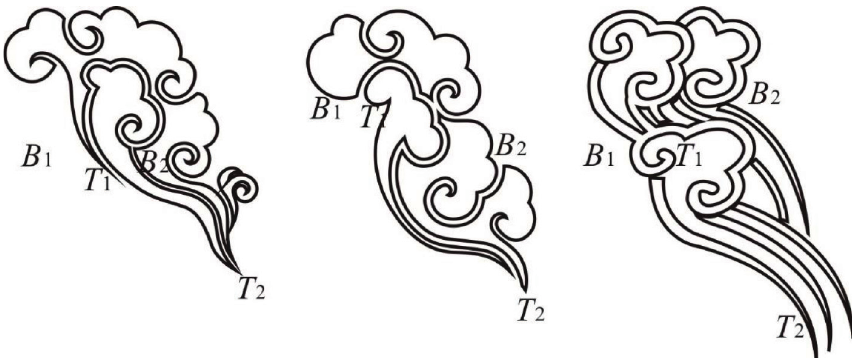
Figure 10: The production process of cloud